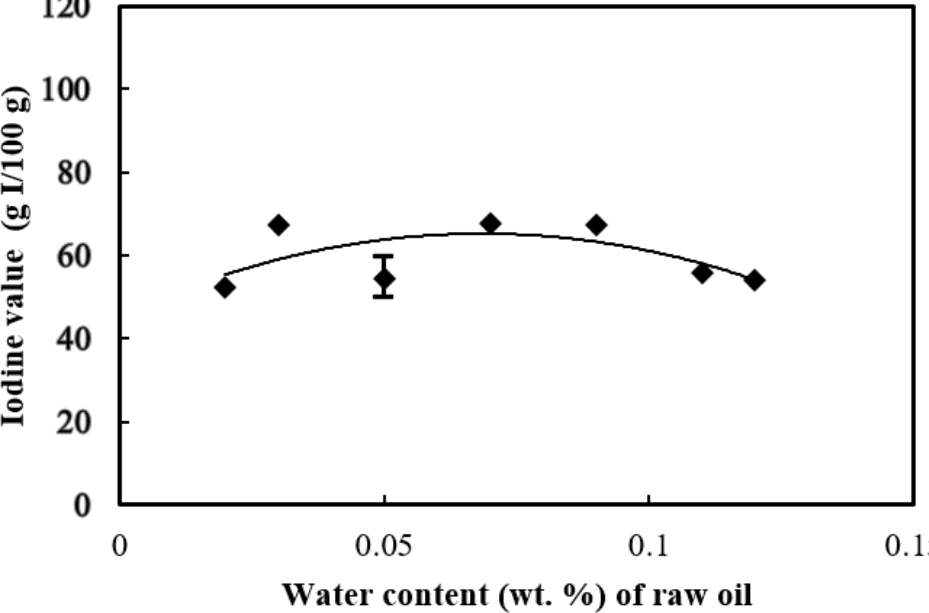
Figure 3. Variations of the iodine value of the biodiesel product with the initial water content in the raw palm oil. raw palm